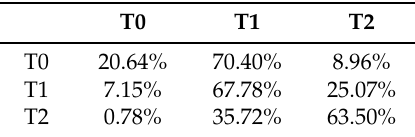
Table 8. PLS predictions for the propranolol set. Confusion matrix for time point prediction using an evenly spaced coding. T0